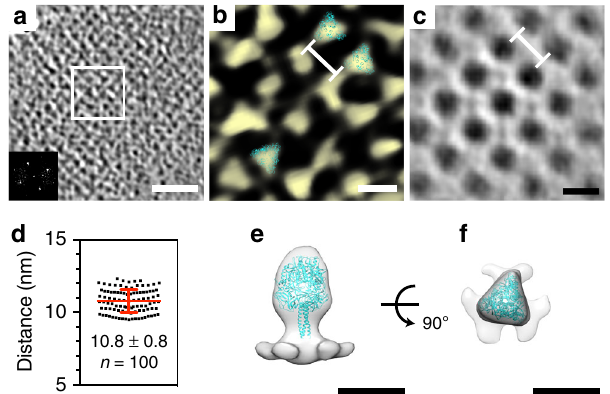
Fig. 3 MeV F glycoprotein forms a 2D paracrystalline lattice with four-fold symmetry. a Tomographic slice showing the F glycoprotein layer from recMeV-(H-118 ∇ 41×)-infected HeLa cells at an assembly site. The inset is the power spectrum of the F layer, which indicates four-fold symmetry with subunit spacing of ~11 nm. Black is density. b The enlarged region ( a ) (white box) with an isosurface rendering showing the F ordering. Three F trimer densities were fi tted using PIV5 pre-fusion F glycoprotein structure (PDB ID: 2B9B). c Sub-volume averaged structure of the F layer showing spacing with four-fold symmetry. Black is density. d Measurements between two nearest neighboring F glycoproteins (white line in b ) indicate an average distance of ~11 nm, consistent with the power spectrum analysis and the sub-volume averaged structure (white line in c ). The error bar represents the standard deviation (s.d.) of 100 measurements (graph data points). e , f Sub-volume average of F glycoprotein trimer indicates F is in the pre-fusion conformational state, validated by model fi tting of PIV5 prefusion F structure (PDB ID: 2B9B). Scale bars are 50 nm ( a ) and 10 nm ( b , c , e , f